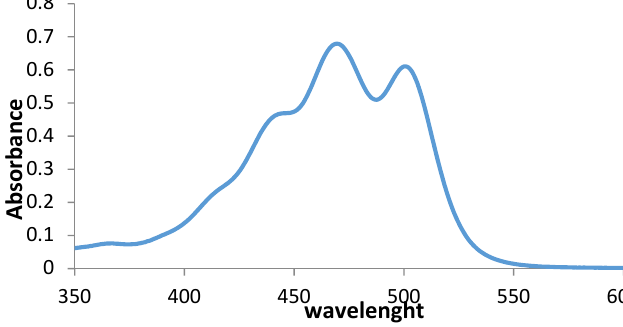
Figure A2. Bixin UV-vis spectrum in Dicloromethane (3 ppm), after extraction.